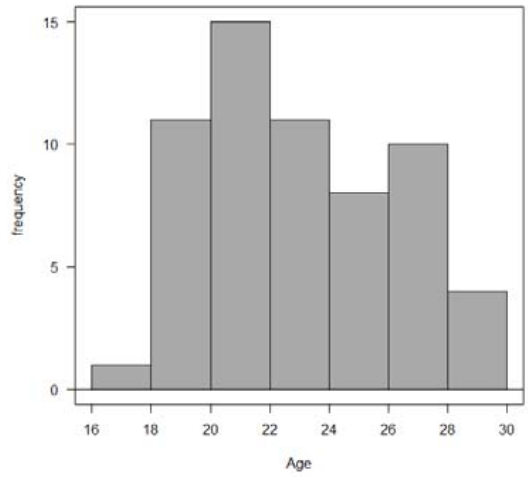
Figure 2. Age distribution of the patients.